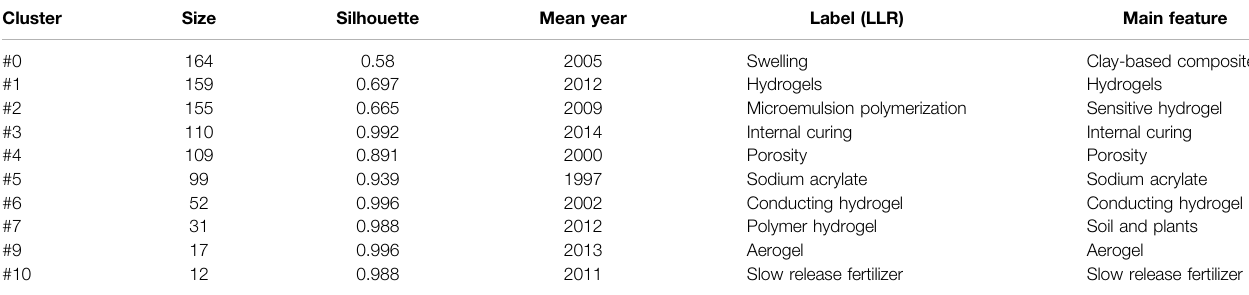
TABLE 2 | Top ten clusters in the co-citation document network of superabsorbents.